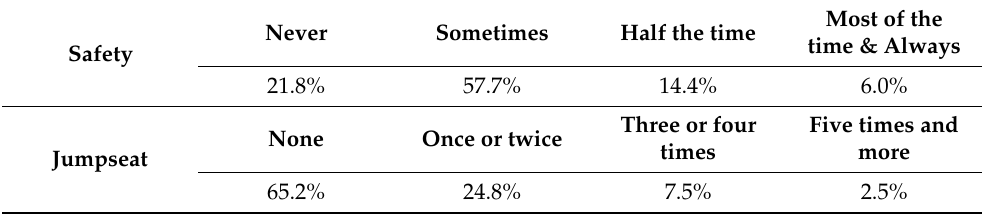
Table 3. Frequency of safety related tasks being compromised by fatigue, and how many times crew fell asleep on the jumpseat (Total n = 930).